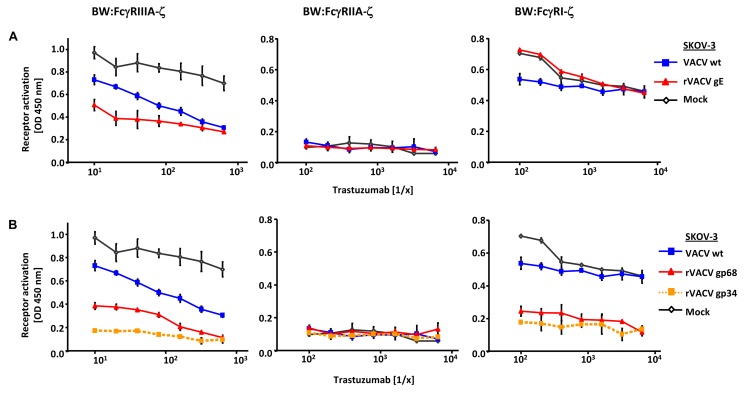
Ectopic expression of HSV-1 gE, HCMV gp68 and HCMV gp34 inhibit IgG1 (trastuzumab) mediated activation of FcγRs.(A) SKOV-3 cells were infected for 24 h with 2 PFU/cell VACV wt and rVACV expressing gE or (B) rVACV expressing gp68 or gp34 before opsonized with trastuzumab at different concentrations for 30 min. After removing of unbound antibodies by repeated washing with D-MEM 10% (vol/vol) FCS, 1×105 BW:FcγR-ζ transfectants per well were added and co-cultivated overnight. BW:FcγR-ζ activation was determined by measuring mIL-2 by ELISA. Three independent replicates were measured, means with standard deviations (error bars) are shown for 3 independent experiments. Significance of results (Student's t-test) are presented in Table S1 as *: p<0.05 **: p<0.01 ***: p<0.001.